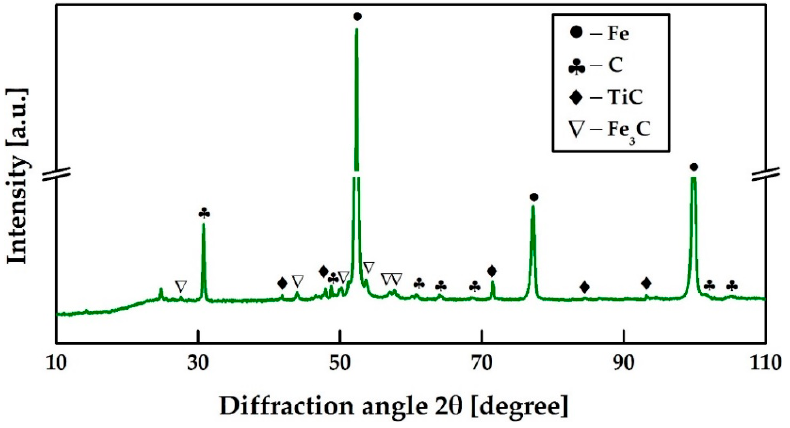
Figure 11. XRD analysis of the pig iron after reductive smelting of the RM at 1750 ° С .